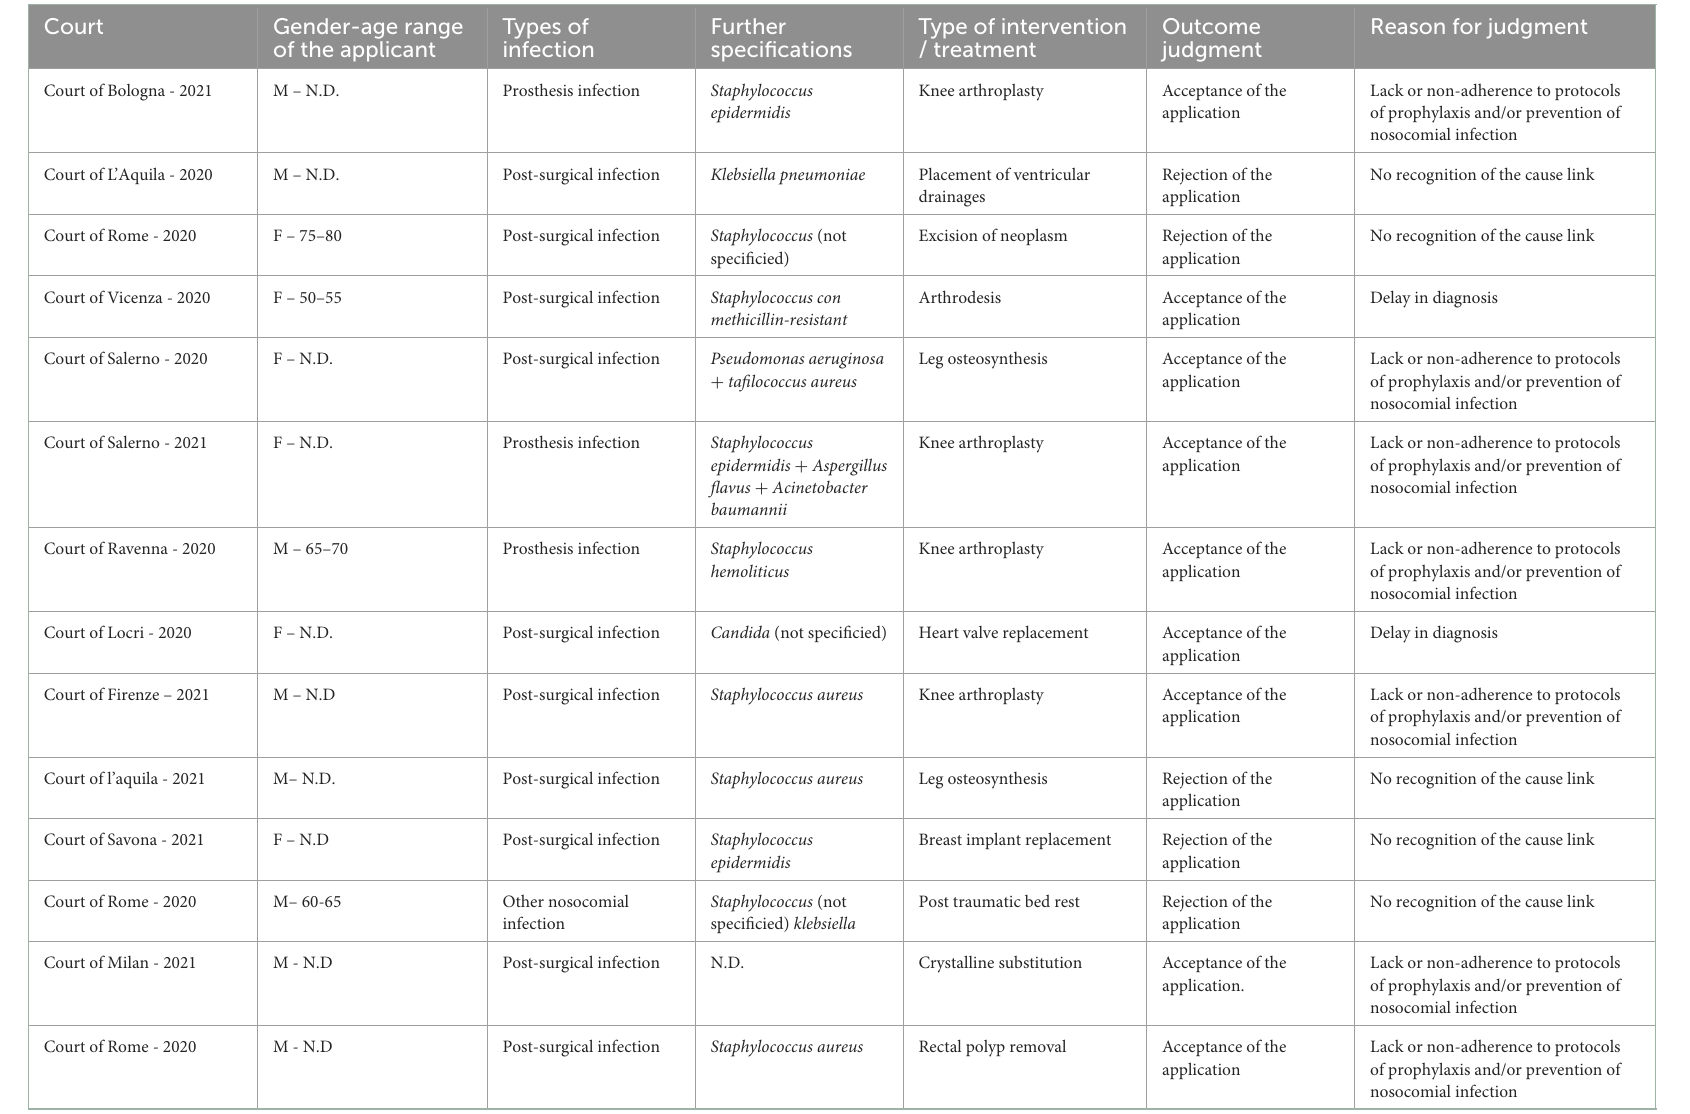
TABLE 1 Request for compensation 2020–2021 in